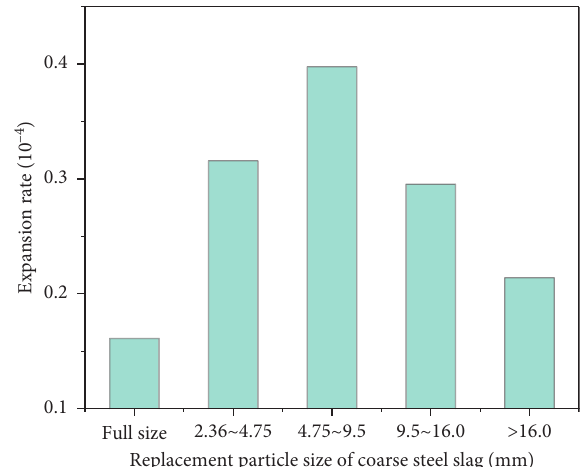
Figure 19: The impact of the replacement particle size of coarse steel slag on the expansion rate of the FSSAC.